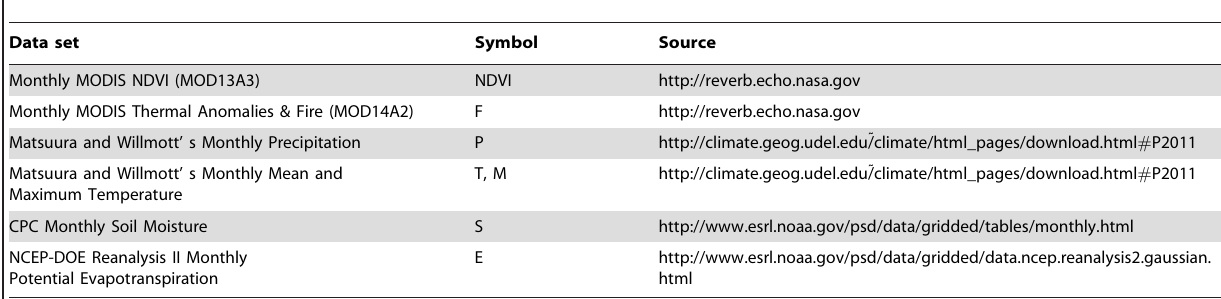
Table 1. Data sets used in DFA analysis and their sources.